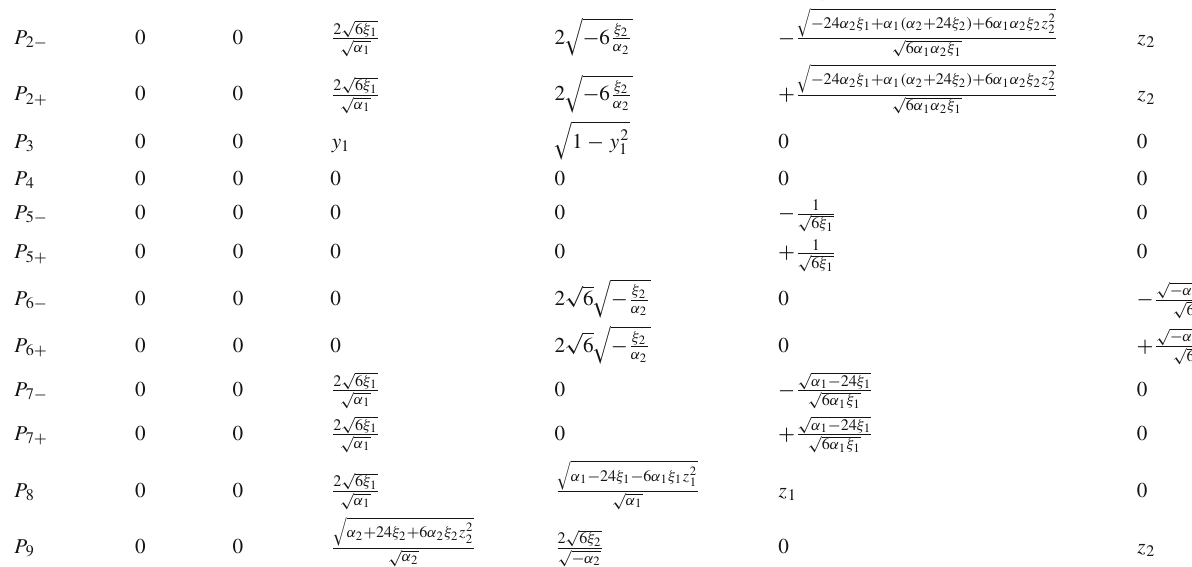
Table 2 The physical features of the critical points, as presented in the